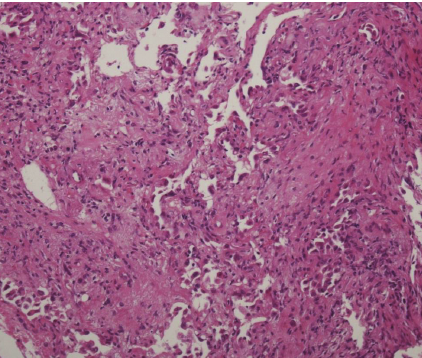
Figure4:Theresultoftransbronchiallungbiopsy.Hematoxylinand eosin (HE) stain revealed diffuse lymphocytes infiltration without any findings of vasculitis (magnification: